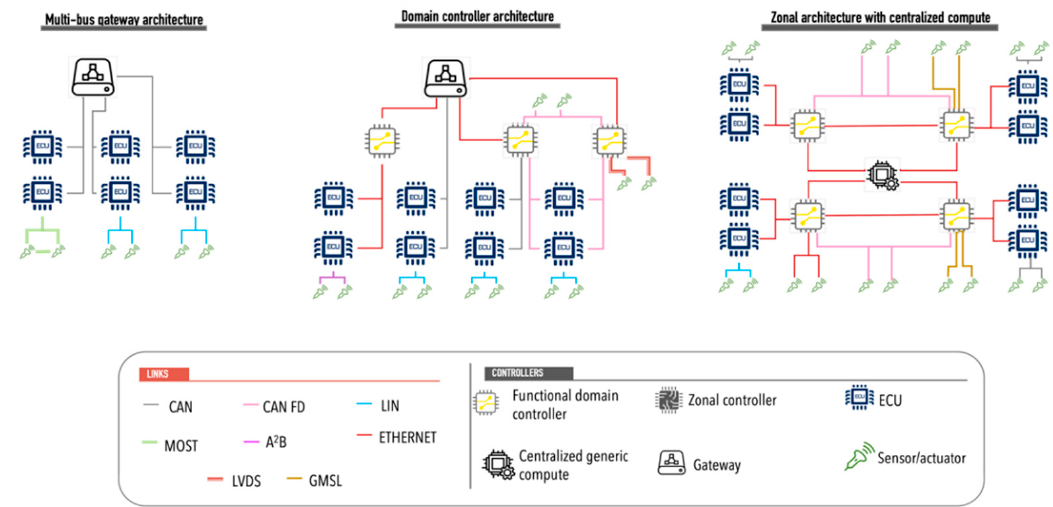
Figure 6. Representation of the different types of architectural models for ACs, adapted from [38].